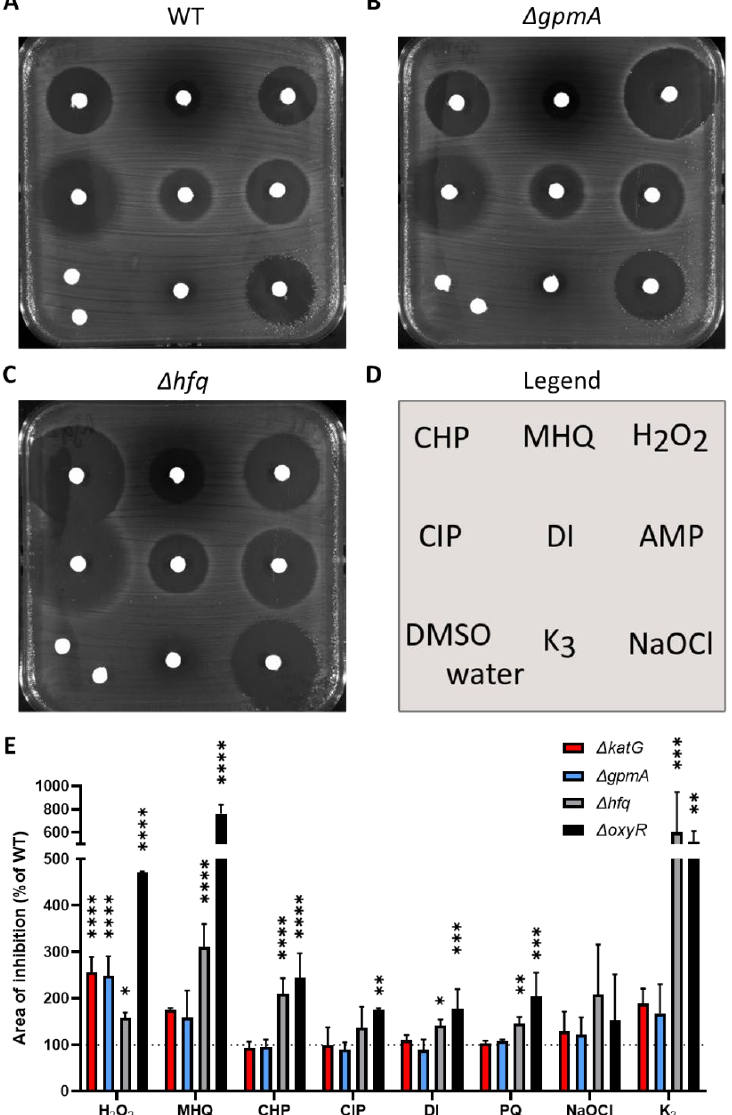
Figure 3. Sensitivity of the Δ oxyR , Δ gpmA and Δ hfq mutants exposed to various oxidants. ( A ) WT, ( B ) Δ gpmA , ( C ) Δ hfq. ( D ) Oxidants applied on each disk (CHP: cumene hydroperoxide, MHQ: methylhydroquinone, H 2 O 2 : hydrogen peroxide, CIP: ciprofloxacin, DI: diamide, AMP: ampicillin, K3: menadione, NaOCl: sodium hypochlorite, DMSO: dimethylsulfoxide). ( E ) Quantification